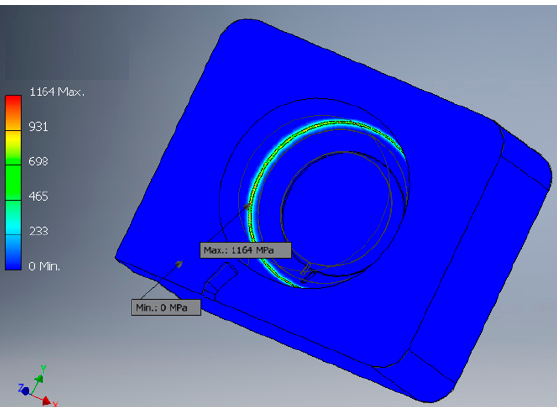
Figure 6. Maximum Von Mises stress acting after loading of shaped intermediate piece.